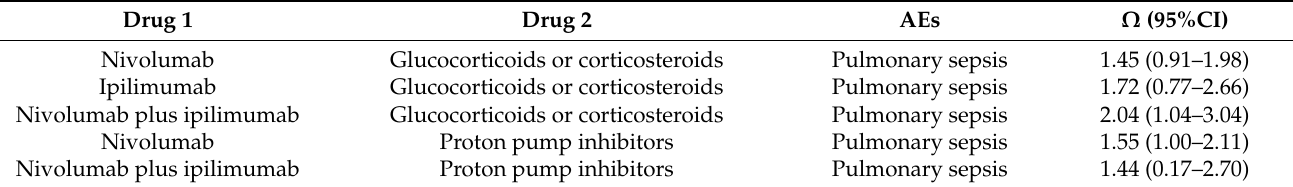
Table 3. Drug–Drug interaction between ICIs and other